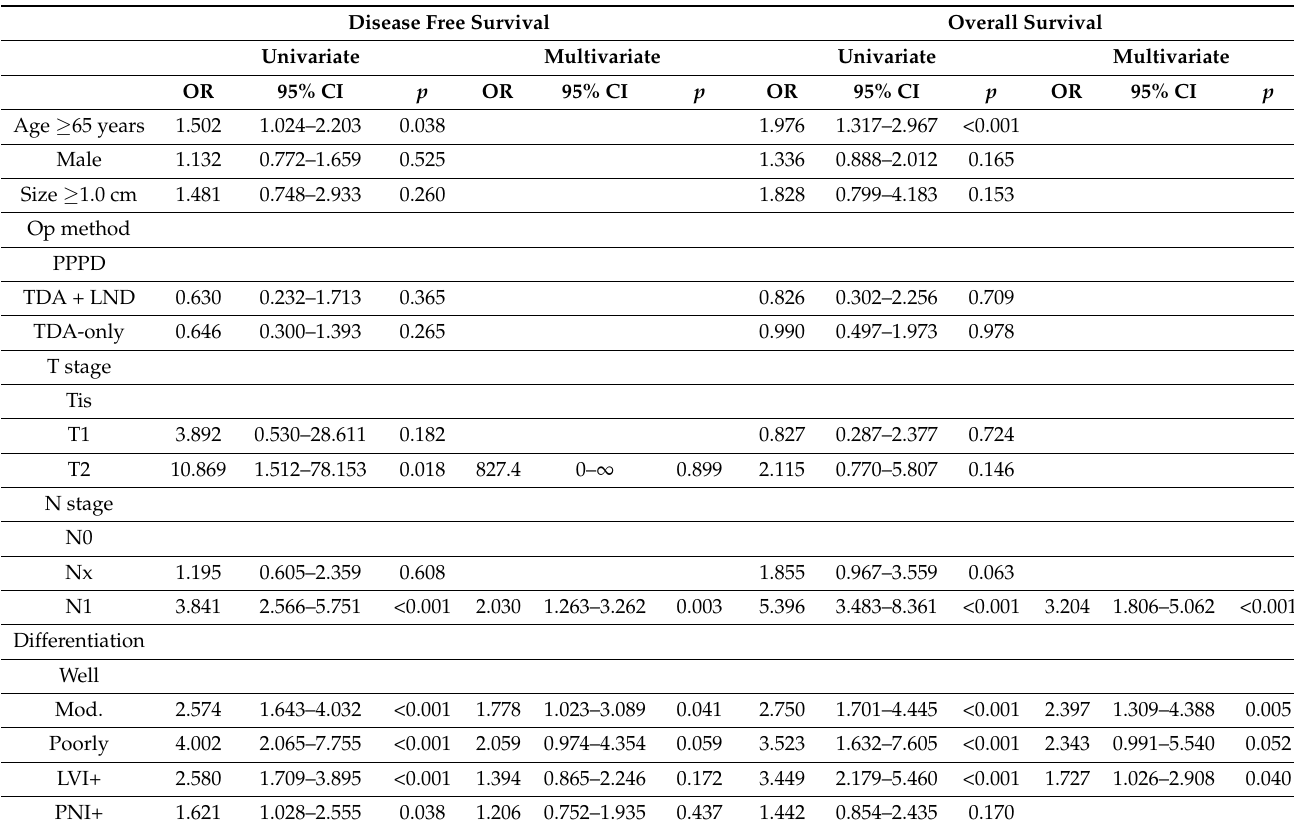
Table 3. Risk factor analysis for 5-year disease-free and overall survival in all patients. Disease Free Survival Overall Survival Univariate Multivariate Univariate